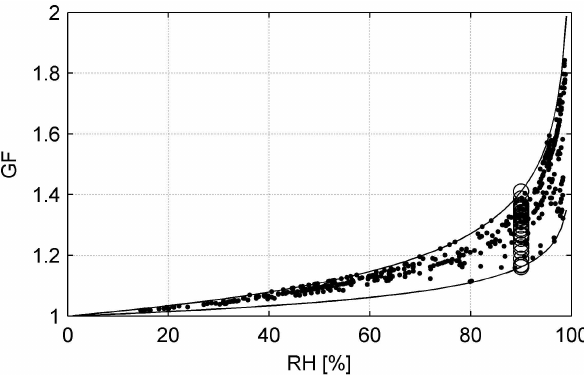
Fig. 6. Growth factors GF(RH) for 165nm dry diameter over the whole RH range, as estimated from the γ law (Eq. 4) and GF(90) measured for the 459 selected events (circles). Also shown (lines) are the γ functions corresponding to the smallest and the largest GF(90)